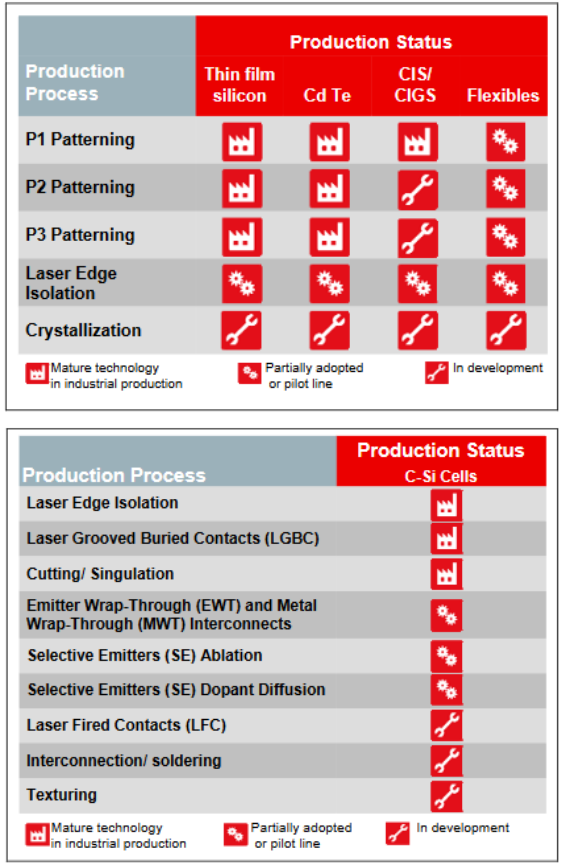
Figure 1. Various applications of laser processing in development and production of solar cells [3].